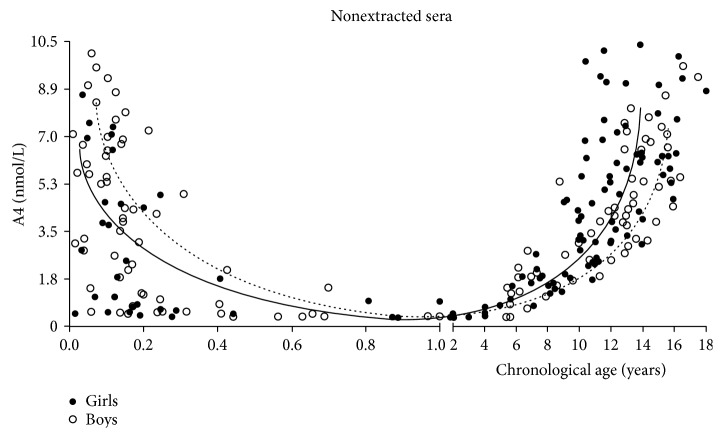
Nonextracted androstenedione concentration in children from birth to adolescence. The curves denote the median NE-A4 concentration for girls (solid line) and for boys (dashed line) throughout childhood.